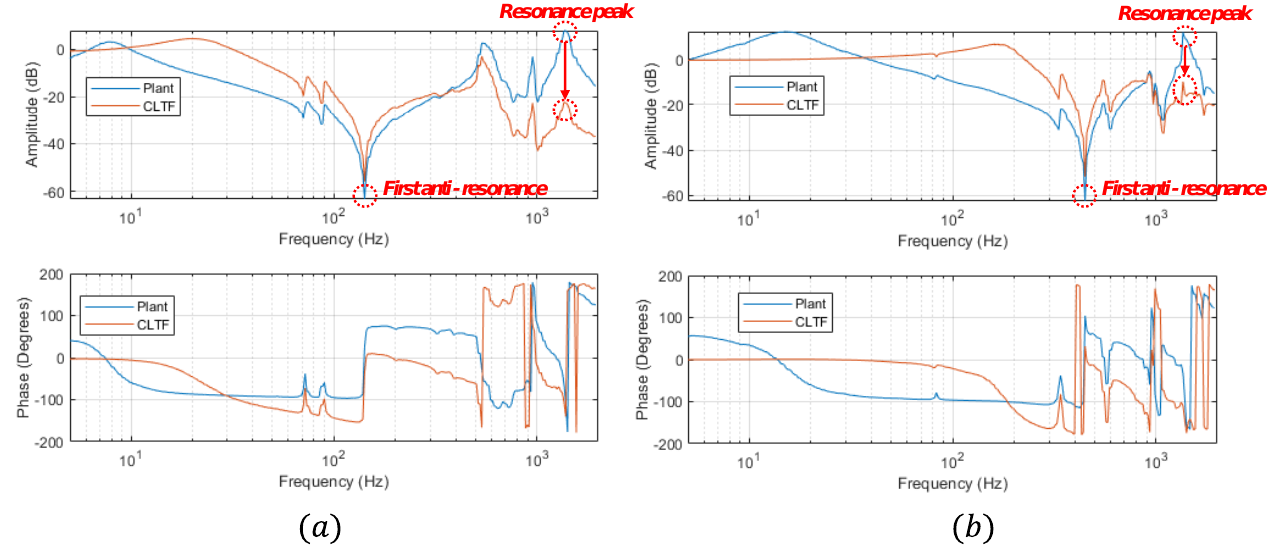
Figure 5. The comparison between the bode plots of each winder: ( a ) the bode plot of the roller with the full film and ( b ) empty film.